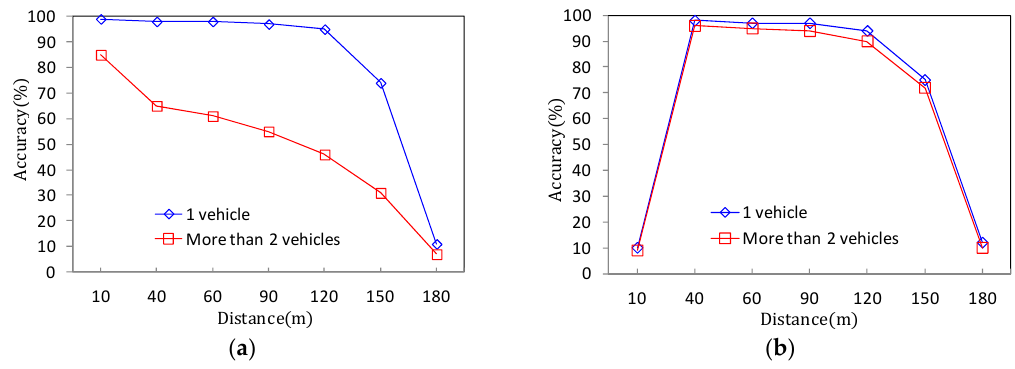
Figure 10. Detection accuracy of RWM according to vehicle distance ( α = 2.5): ( a ) 1 m height of radar installation; ( b ) 2 m height of radar installation.